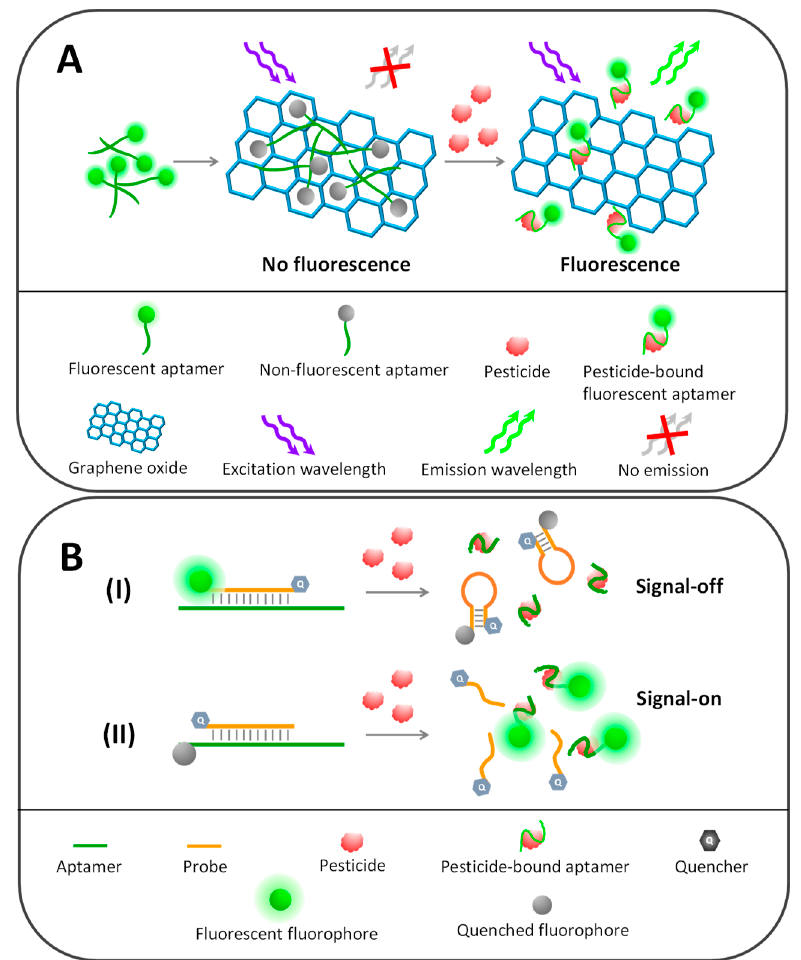
Figure 4. Schematic representation of fluorometric aptasensors for pesticide detection. ( A ) Fluorescence quenching and aptamer binding properties of graphene oxide and related carbon nanomaterials. ( B ) Fluorescent aptasensors using complementary probes: dual-labelled (I) and single-labelled (II) fluorescent probe.